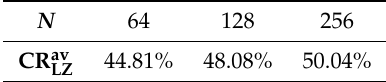
Table 3. Compression rates for LZ77.